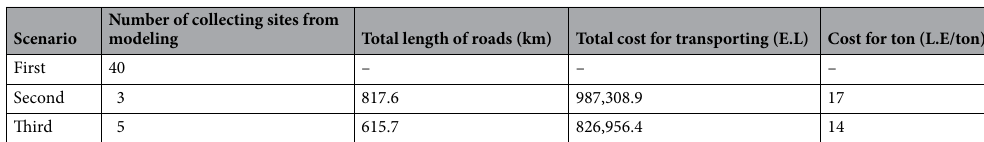
Table 3. Compare between three scenarios of